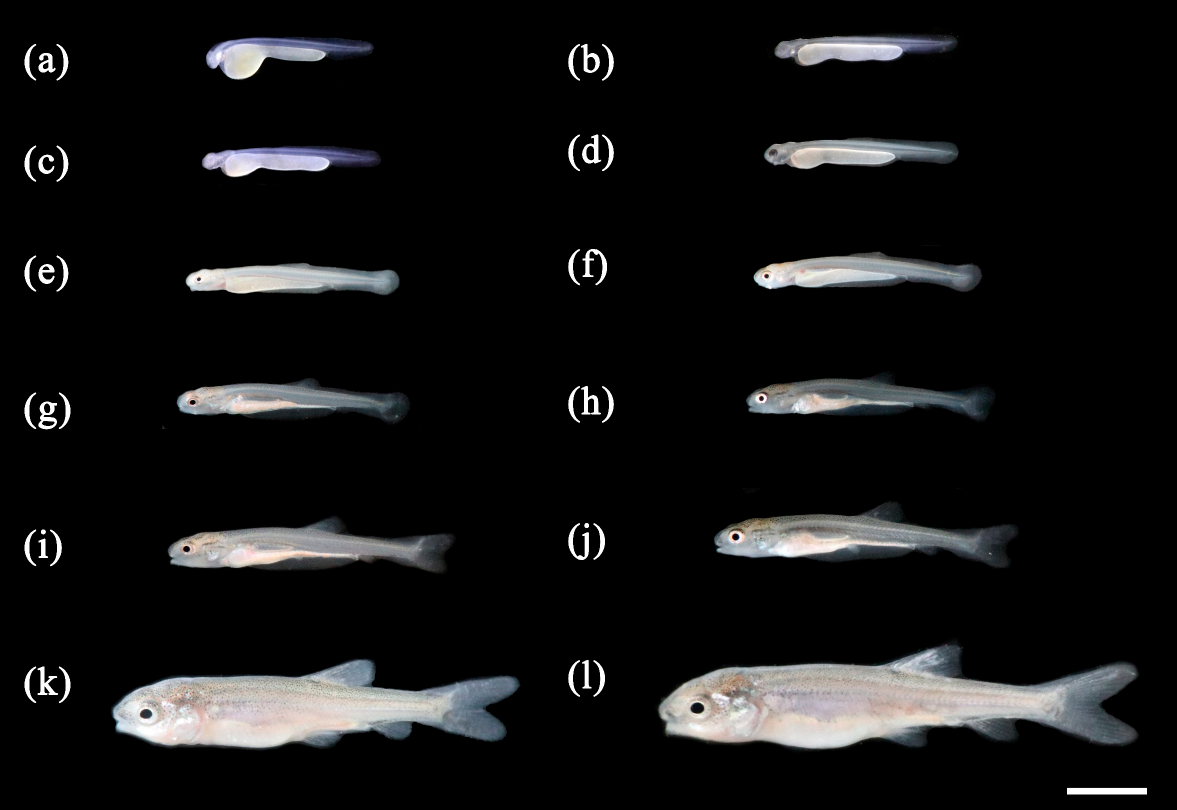
Figure 3. Morphological development of S. waltoni Regan during larval and juvenile periods. Larvae at 0 DPHs, 10.71 mm TL ( a ); 1 DPHs, 11.20 mm TL ( b ); 2 DPHs, 11.59 mm TL ( c ); 4 DPHs, 12.57 mm TL ( d ); 8 DPHs, 13.81 mm TL ( e ); 11 DPHs, 14.78 mm TL ( f ); 16 DPHs, 15.17 mm TL ( g ); 18 DPHs, 16.01 mm TL ( h ); 23 DPHs, 18.35 mm TL ( i ); 25 DPHs, 19.65 mm TL ( j ); 50 DPHs, 25.41 mm TL ( k ); 60 DPHs, 30.10 mm TL ( l ). Scale bars = 5 mm.